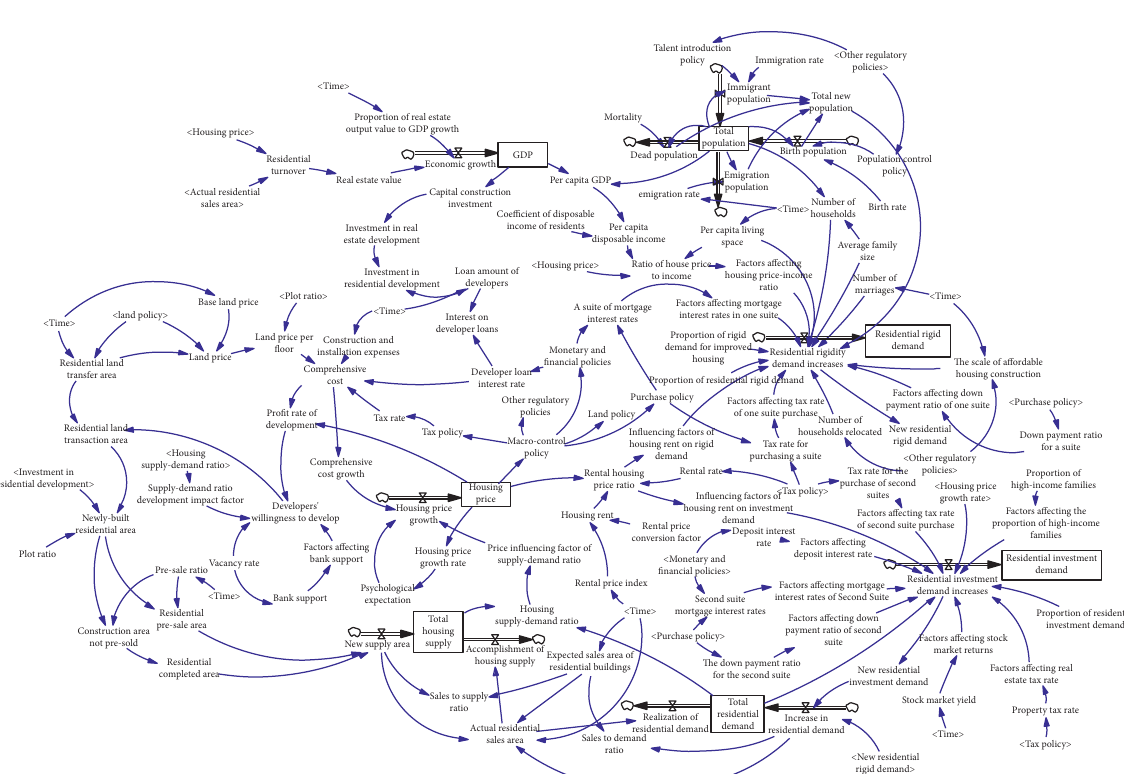
Figure 9: Flow chart of residential price